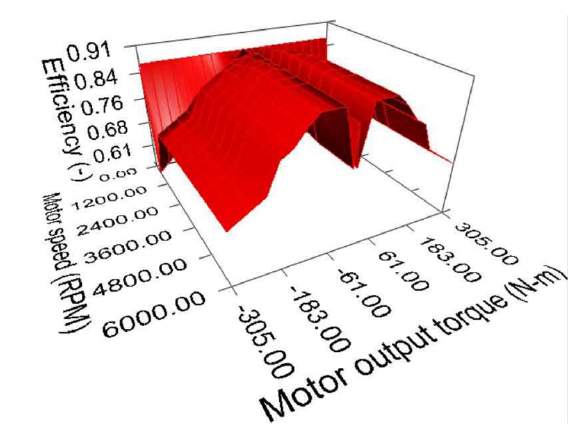
Figure 13. Motor efficiency map comparing motor output torque, motor speed, and efficiency: RPM, revolutions per minute.